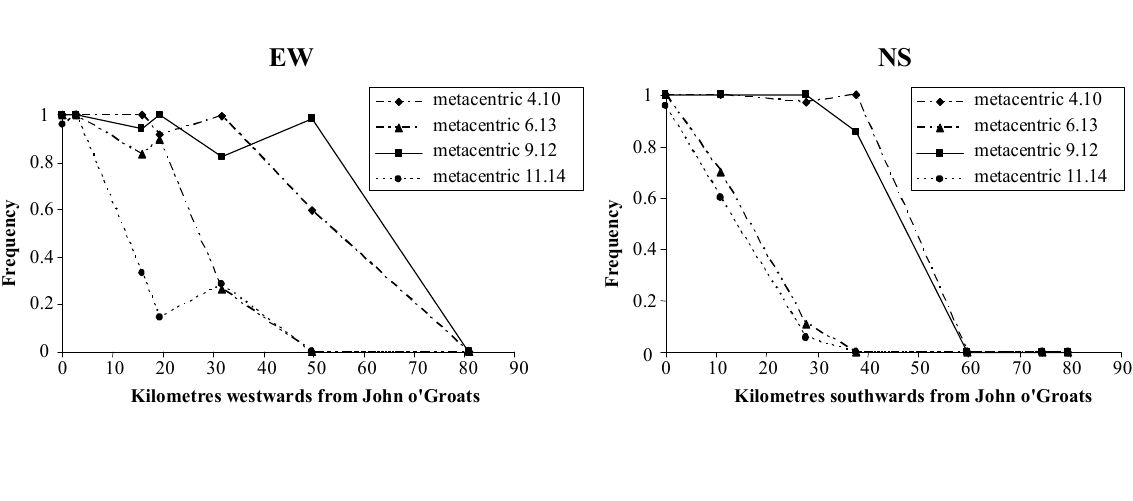
Figure 5. Transects across the John o’Groats-standard hybrid zone to the west and south of John o’Groats, showing metacentric clines [26,27,29].